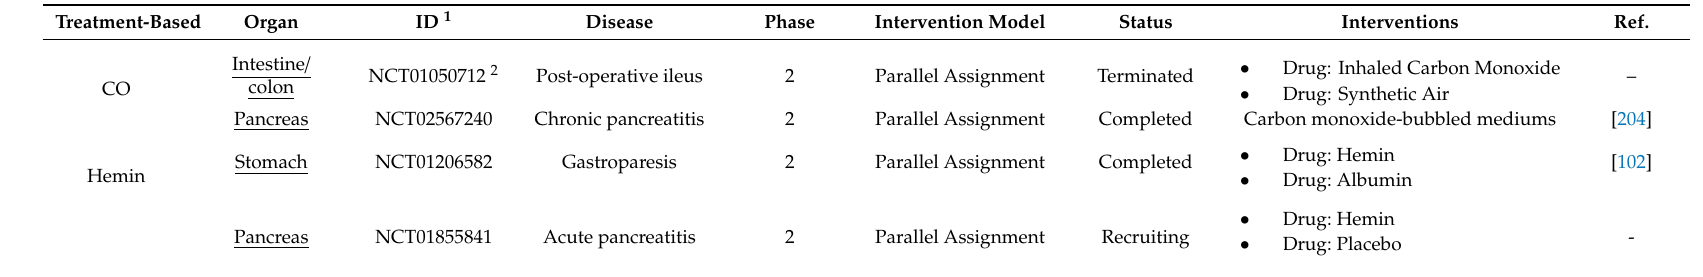
Table 3. Clinical trials in which CO and Hemin have been used as